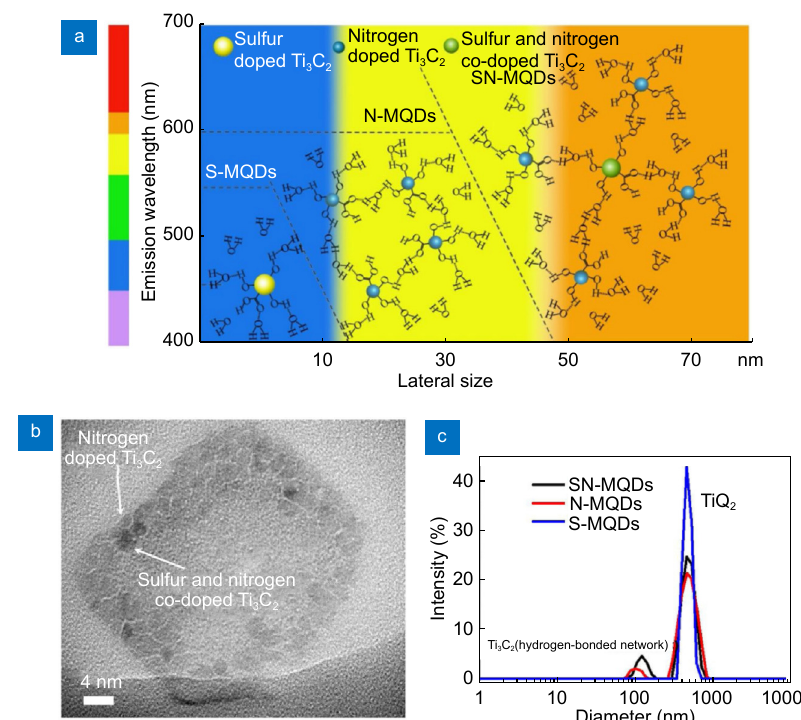
Fig. 8 | ( a ) Schematic of the molecular interactions and light-emitting mechanism of MQDs in water. ( b ) The corresponding HRTEM image of SN- MQDs in relation to the mechanism. ( c ) DLS size distributions of the synthesized MQDs in deionized water. Figures were reproduced with per- mission from ref. 30 . Copyright 2019,